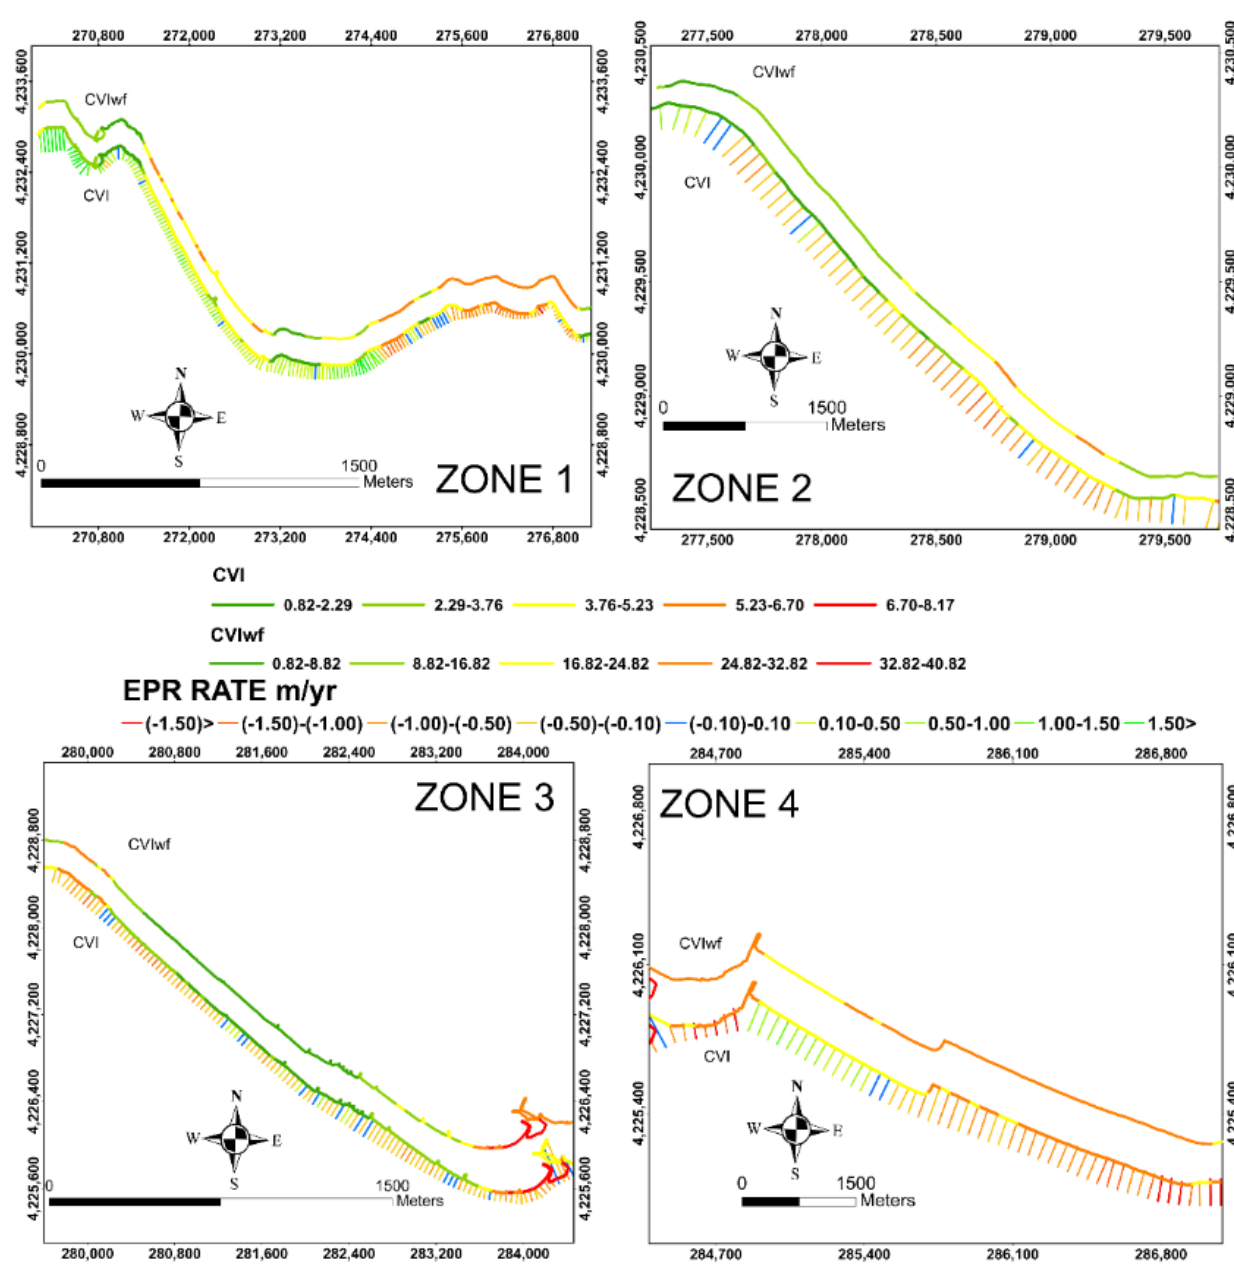
Figure 9. Comparison between the EPR and the vulnerability classes in Zones 1–4. Zones 5, 6, 7 and 8 have smaller rates of erosion compared with Zones 1, 2, 3 and